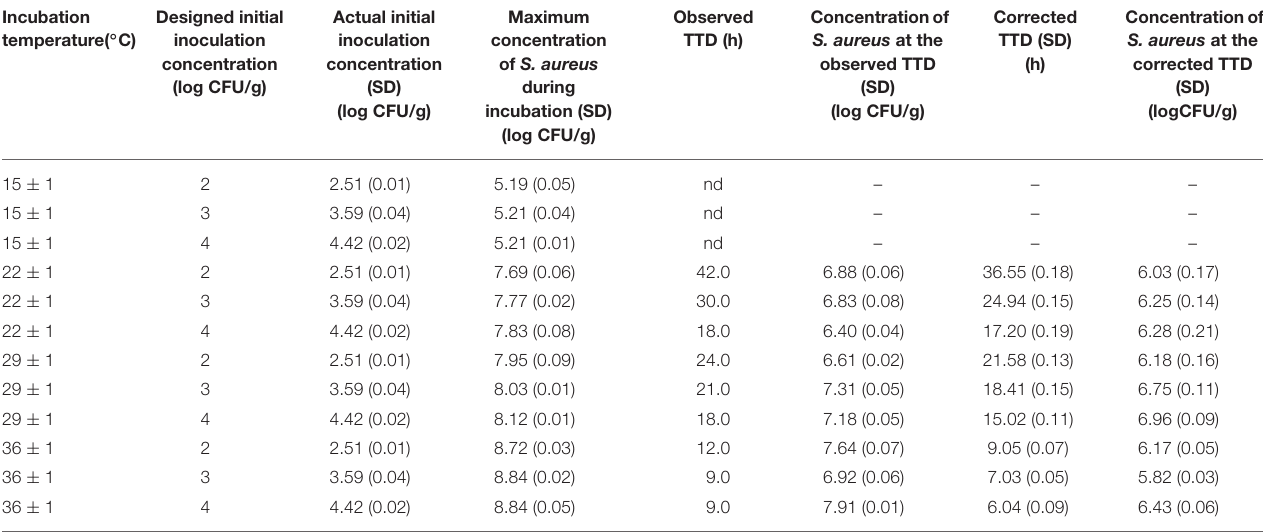
TABLE 3 | TTD of SEA in cooked chicken meat under various combinations of incubation temperatures and initial inoculation concentrations of S. aureus . Incubation Designed initial temperature( ◦ C)